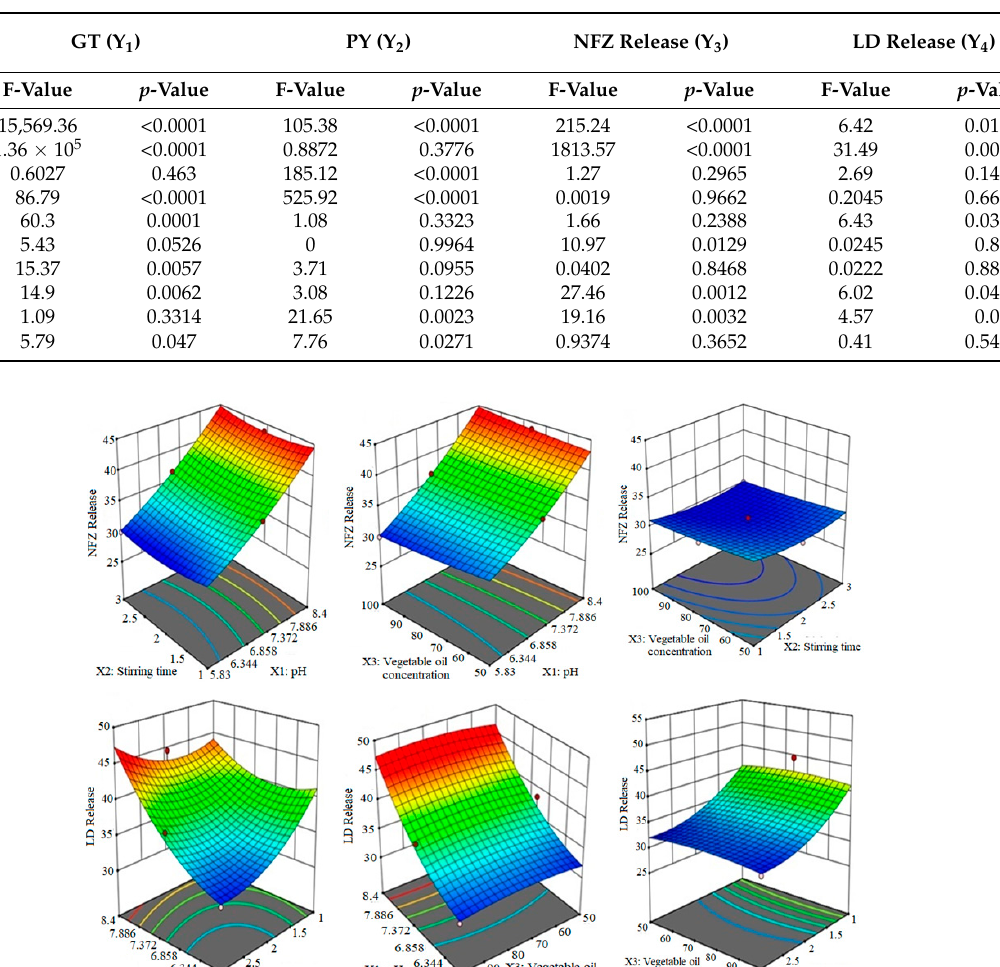
Table 1. Results of ANOVA indicating the effect of formulation variables on studied responses with their p -value.